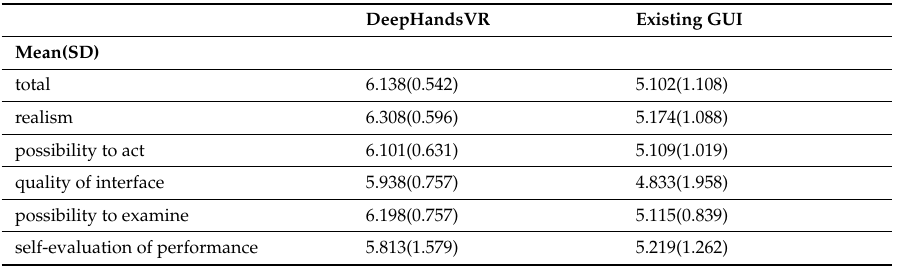
Table 2. Statistical comparative analysis results for presence with the proposed hand